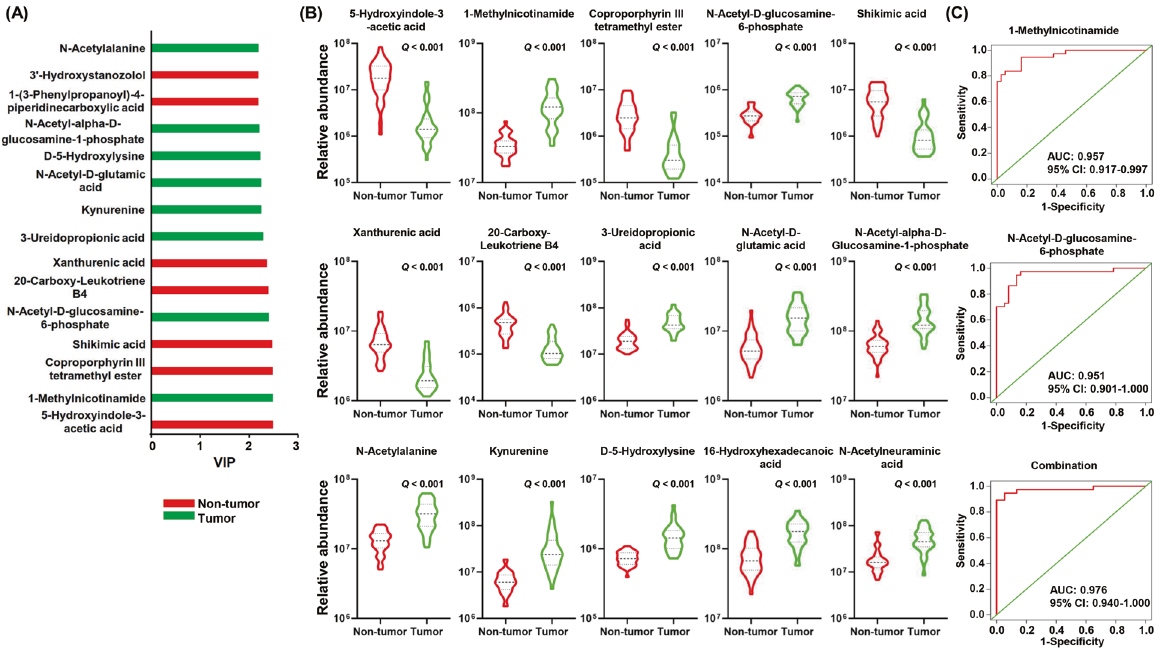
Fig. 4 Identi fi cation of metabolite biomarkers for discriminating gastric tumor tissues from non-tumor tissues. A The top 15 metabolites according to VIP values are displayed. VIP, variable importance in projection. B Among the 15 metabolites, the relative abundance of 8 metabolites was higher, but the relative abundance of the rest of the metabolites was lower in the tumor tissues than the non-tumor tissues. Q value, corrected P value. C ROC analysis for 1-methylnicotinamide, N -acetyl-D-glucosamine-6-phosphate, and the combination of the two metabolites. ROC, receiver operating